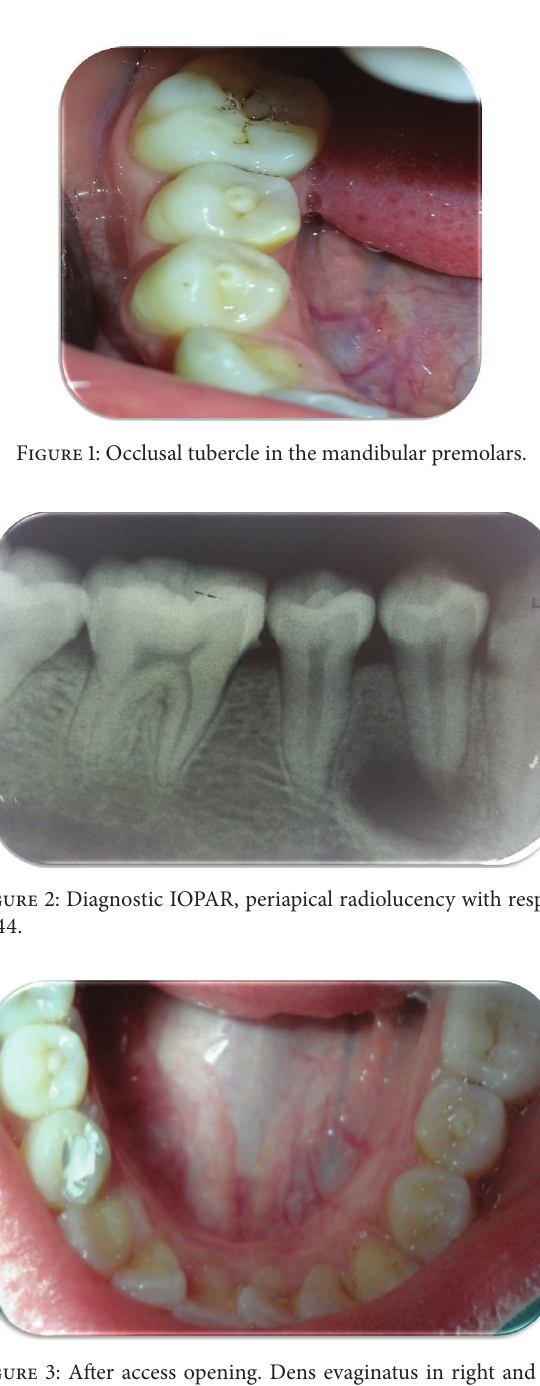
Figure 3: After access opening. Dens evaginatus in right and left premolars.